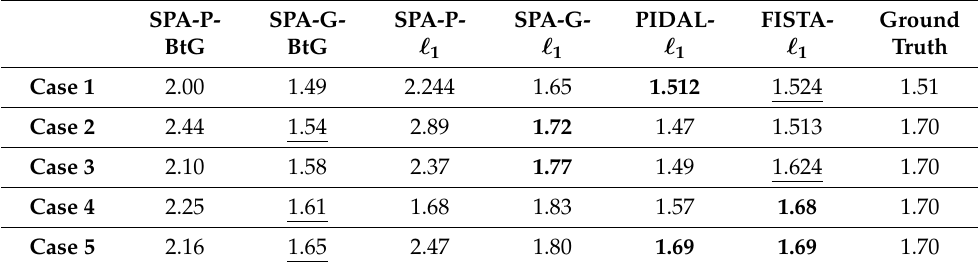
Figure 15. The IDEAL response matrix: Activity estimation using pin pixels averaging using existing methods. The regularization parameter β was set to 1 × 10 − 5 in the four methods. Table 1. The IDEAL response matrix: Comparison of activity estimations ( × 10 7 ), represented by number of particle (NPS), for the proposed approaches and the four existing methods. NPS is the mean of active pin pixels in each case. Estimated activities close to the ground truth are highlighted in bold. Second close values are